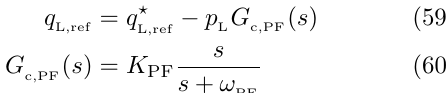
Figure 17: Comparison of frequency responses for the transfer function x x /q (cid:63) (red). p L,ref